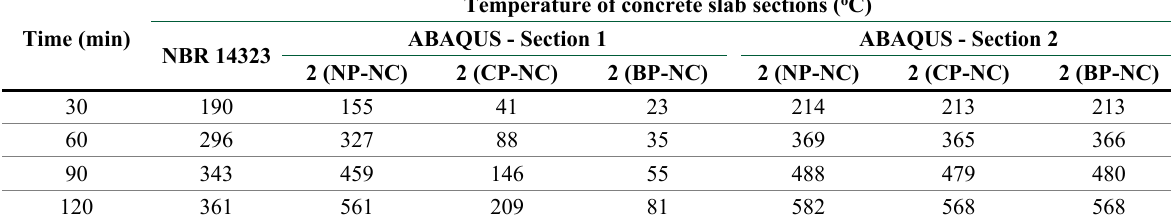
Table 3. Uniform temperature in the concrete slab